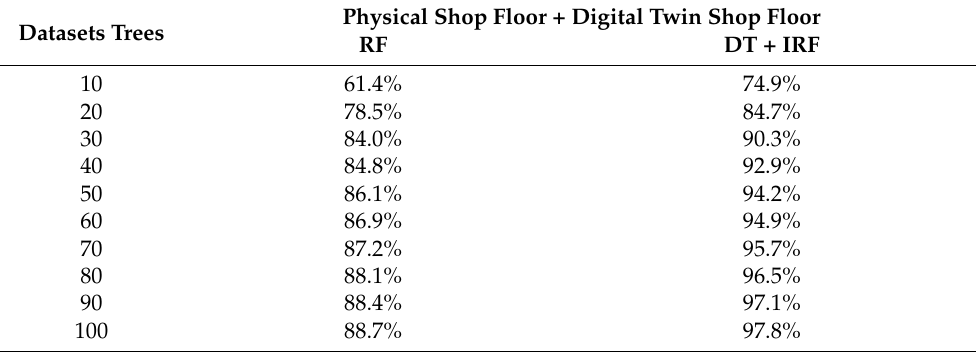
Table 2. Comparison of prediction accuracy between DT and DT + IRF algorithms.